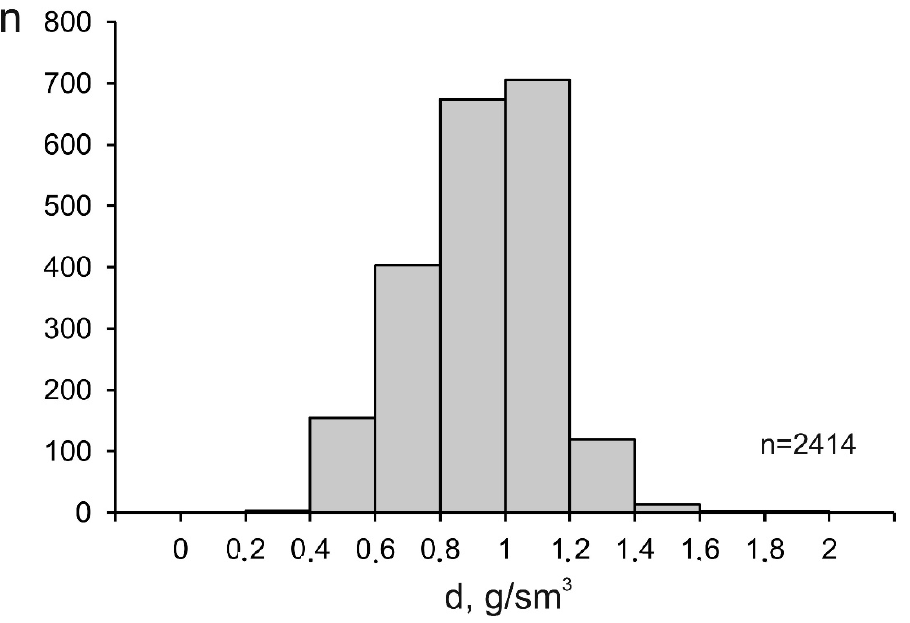
Figure 7. Histogram of the density of mineralizing fluids at porphyry deposits. Some systematic differences were found between the average and maximum values of the parameters of the mineralizing fluids at porphyry deposits of various types (Table 3, Figure 8).